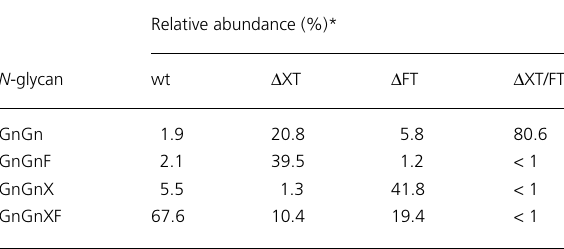
Table 1 Liquid chromatography-electrospray ionization-mass spectrometry (LC-ESI-MS) analysis of the glycosylated Fc peptides EEQYN297STYR and TKPREEQYN297STYR from